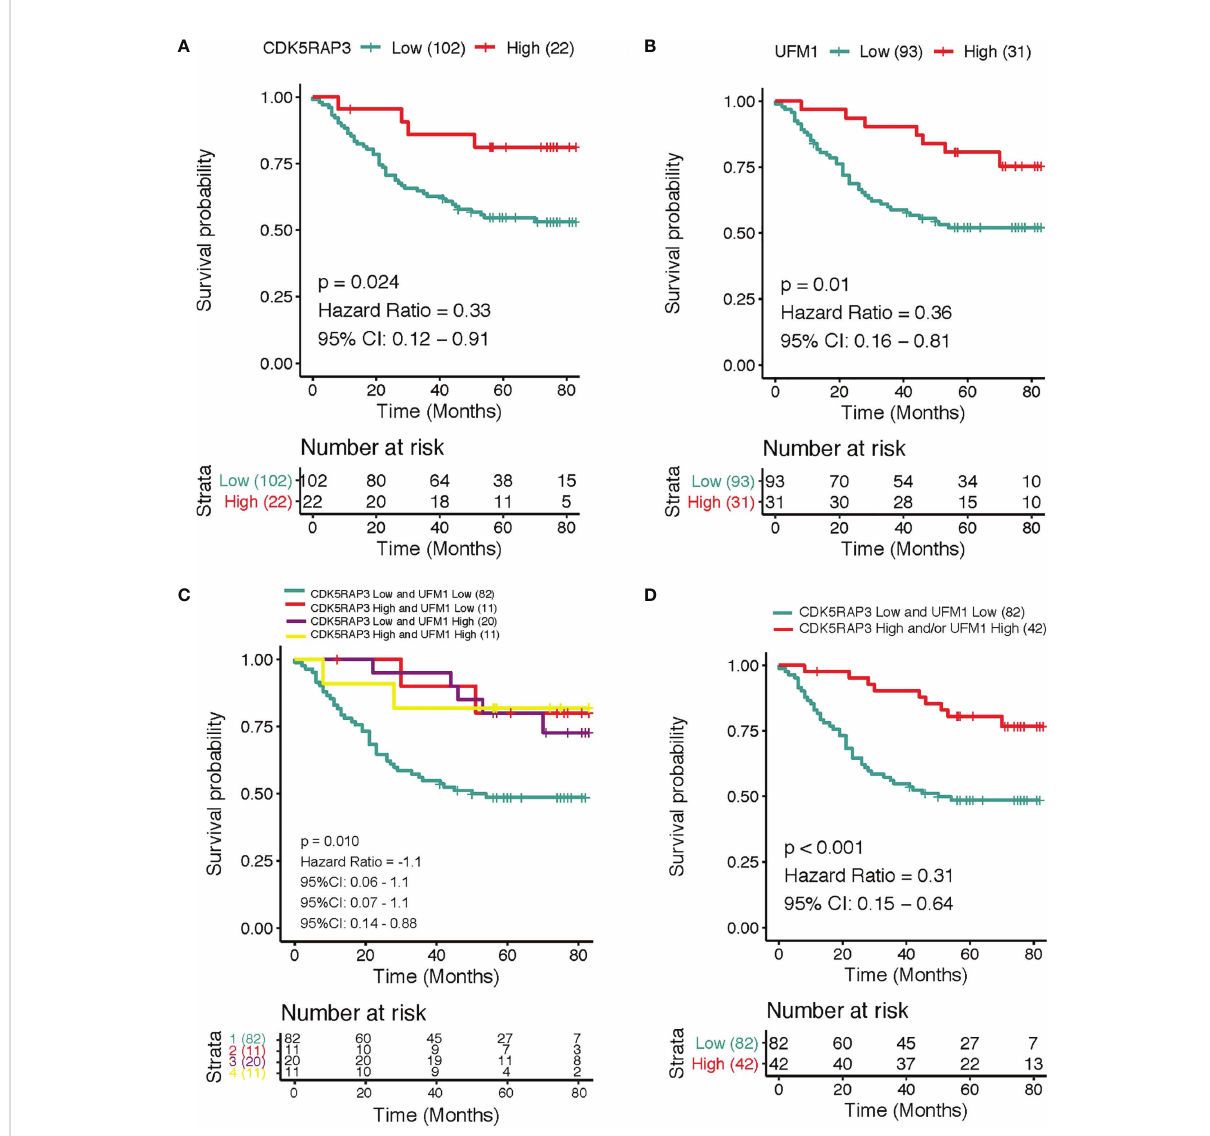
FIGURE 4 OverallsurvivalaccordingtodifferentexpressionlevelsofCDK5RAP3andUFM1. (A) Overallsurvivalofgastriccancerpatientswithlowandhighexpressionof CDK5RAP3. (B) OverallsurvivalofgastriccancerpatientswithlowandhighexpressionofUFM1. (C) Overallsurvivalofgastriccancerpatientswithdifferentco- expressionofCDK5RAP3andUFM1. (D)